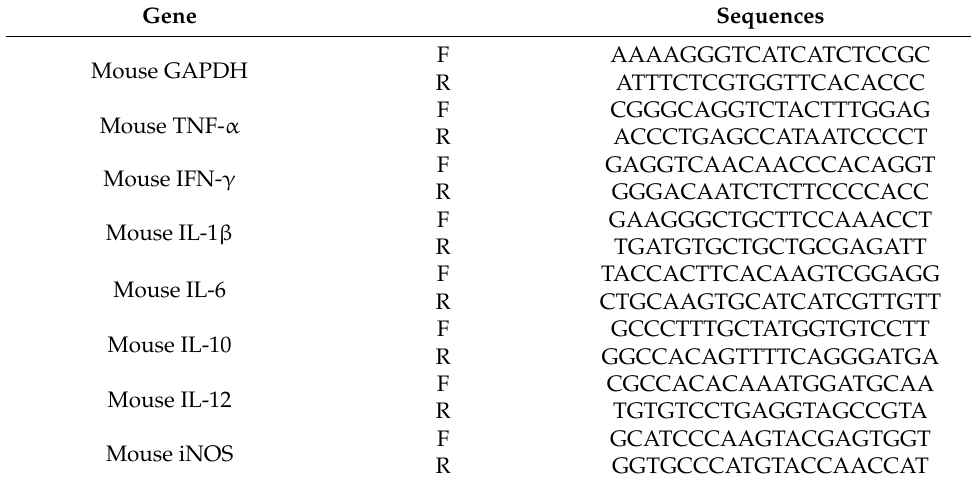
Table 1. Primer sequences for real-time